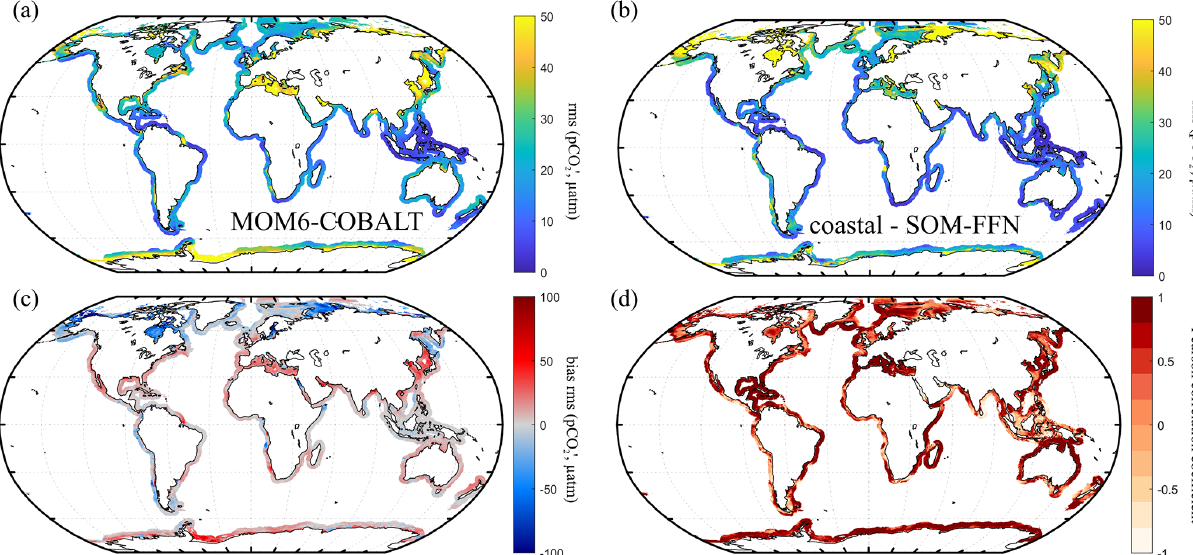
Figure 5. Seasonal variability in ocean p CO 2 (µatm). Seasonal amplitude (a) simulated by MOM6-COBALT model and (b) in the coastal SOM-FFN product, and (c) bias between the model and coastal SOM-FFN seasonal amplitude (red indicates that simulated amplitude exceeds coastal SOM-FFN). The seasonal amplitude is expressed as the root mean square of the monthly climatology p CO 2 anomalies (rms p CO (cid:48) , µatm). (d) Pearson correlation coefficient of the regression between the seasonal p CO 2 cycles calculated by MOM6-COBALT 2 and coastal SOM-FFN. A value of 1 indicates that both signals are perfectly in phase with one another, while a value of − 1 represents a complete phase